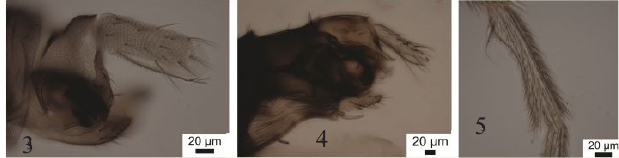
Figs 3-5. Puliciphora males. 3, species A, left face of hypopygium; 4-5, species B; 4, left face of hypopygium; 5, front basitarsus.